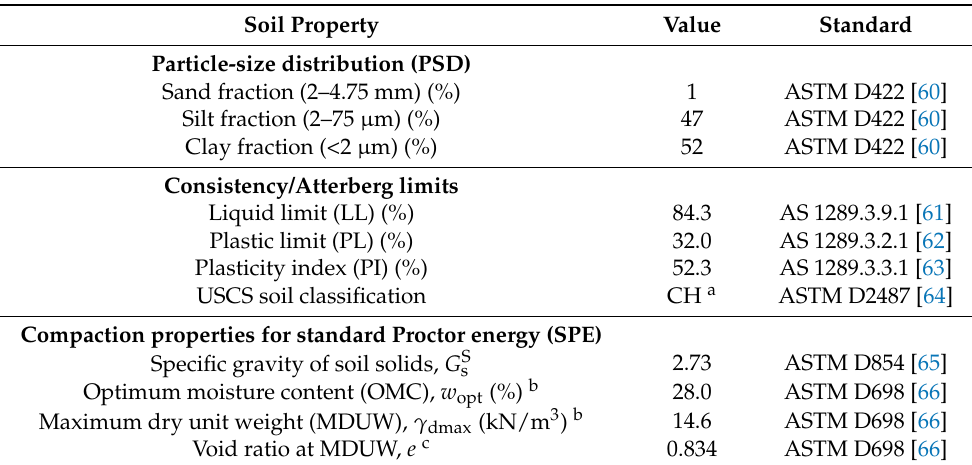
Table 1. Physical and mechanical properties of the test